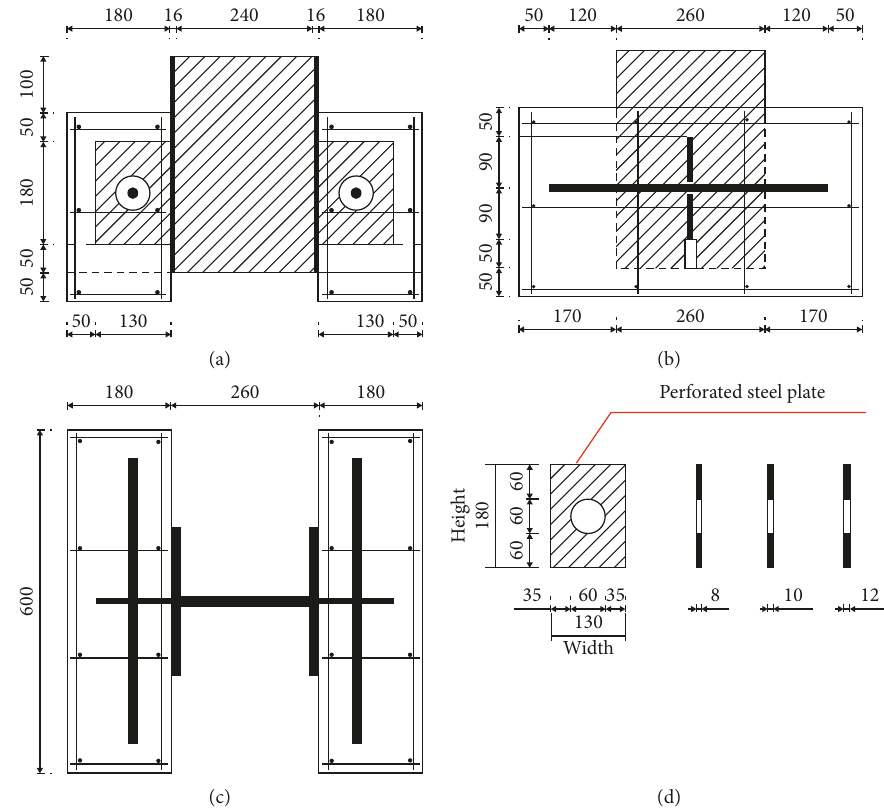
Figure 3: Dimensions for push-out specimens: (a) front view; (b) side view; (c) top view; (d) geometric dimensions of the perforated steel plate. (All dimensions are in